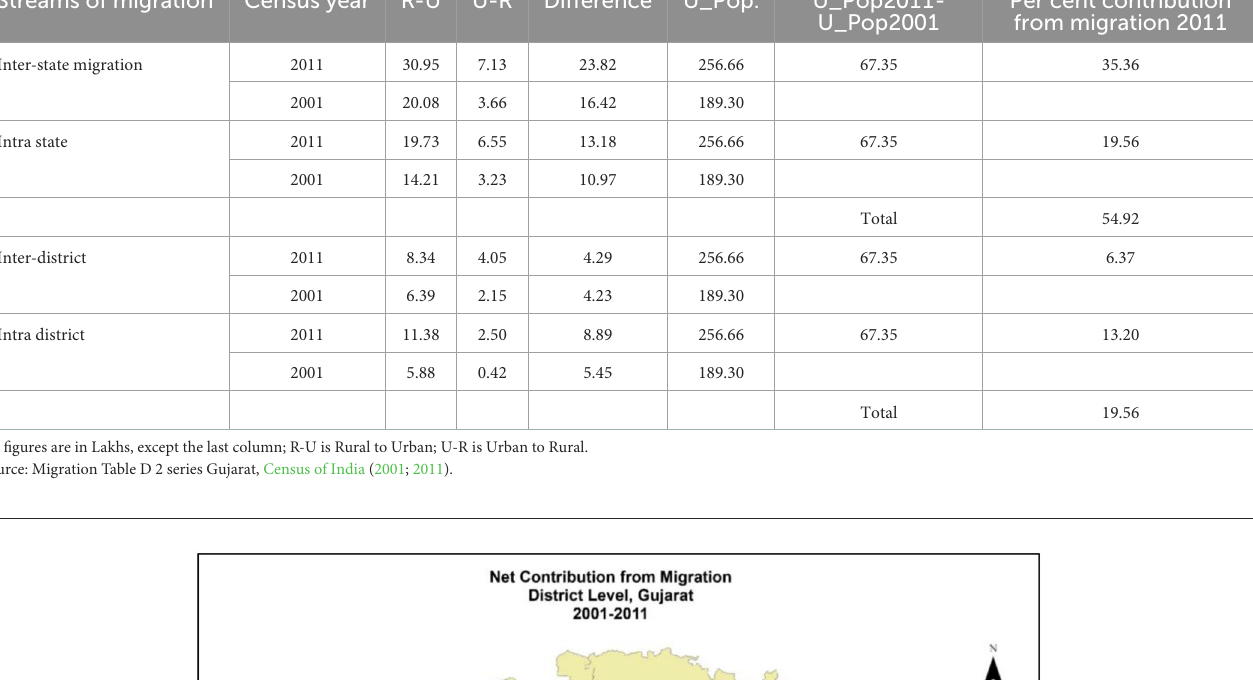
TABLE 11 Trends and pattern of migration in Gujarat − 2001 to 2011. Streams of migration